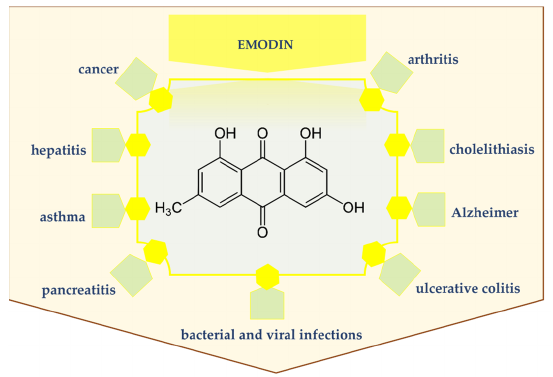
Figure 2. Emodin’s potential in human disease treatment.